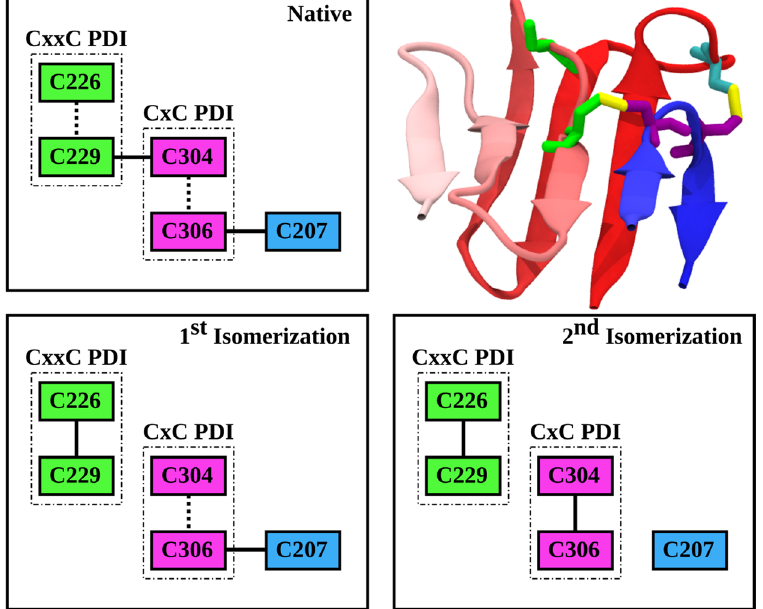
Figure 6. E1 disulfide isomerization. E1 β -sheets structure in the native conformation is depicted in cartoon and colored according to residue position (red residues are located at the N-terminal, blue residues at the C-terminal) to highlight long-range β -strand coupling. Cysteines are represented in licorice and colored according to the scheme. In the three boxes, cysteine coupling in native conditions and after the first and second disulfide isomerization steps are represented. Continuous lines connecting each cysteine represent disulfide bridges, while dashed lines highlight proximal cysteines in the linear